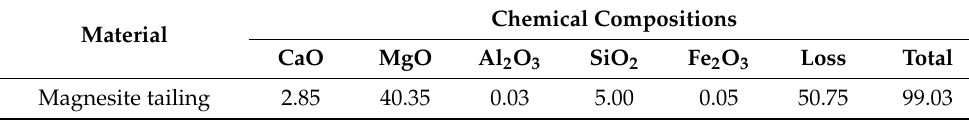
Table 2. Chemical composition of magnesite tailing (%).